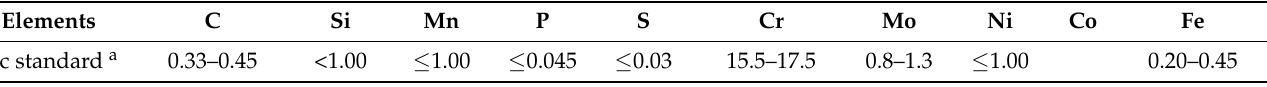
Table 1. 1.4122 (X35CrMo17): chemical composition in mass per cent.